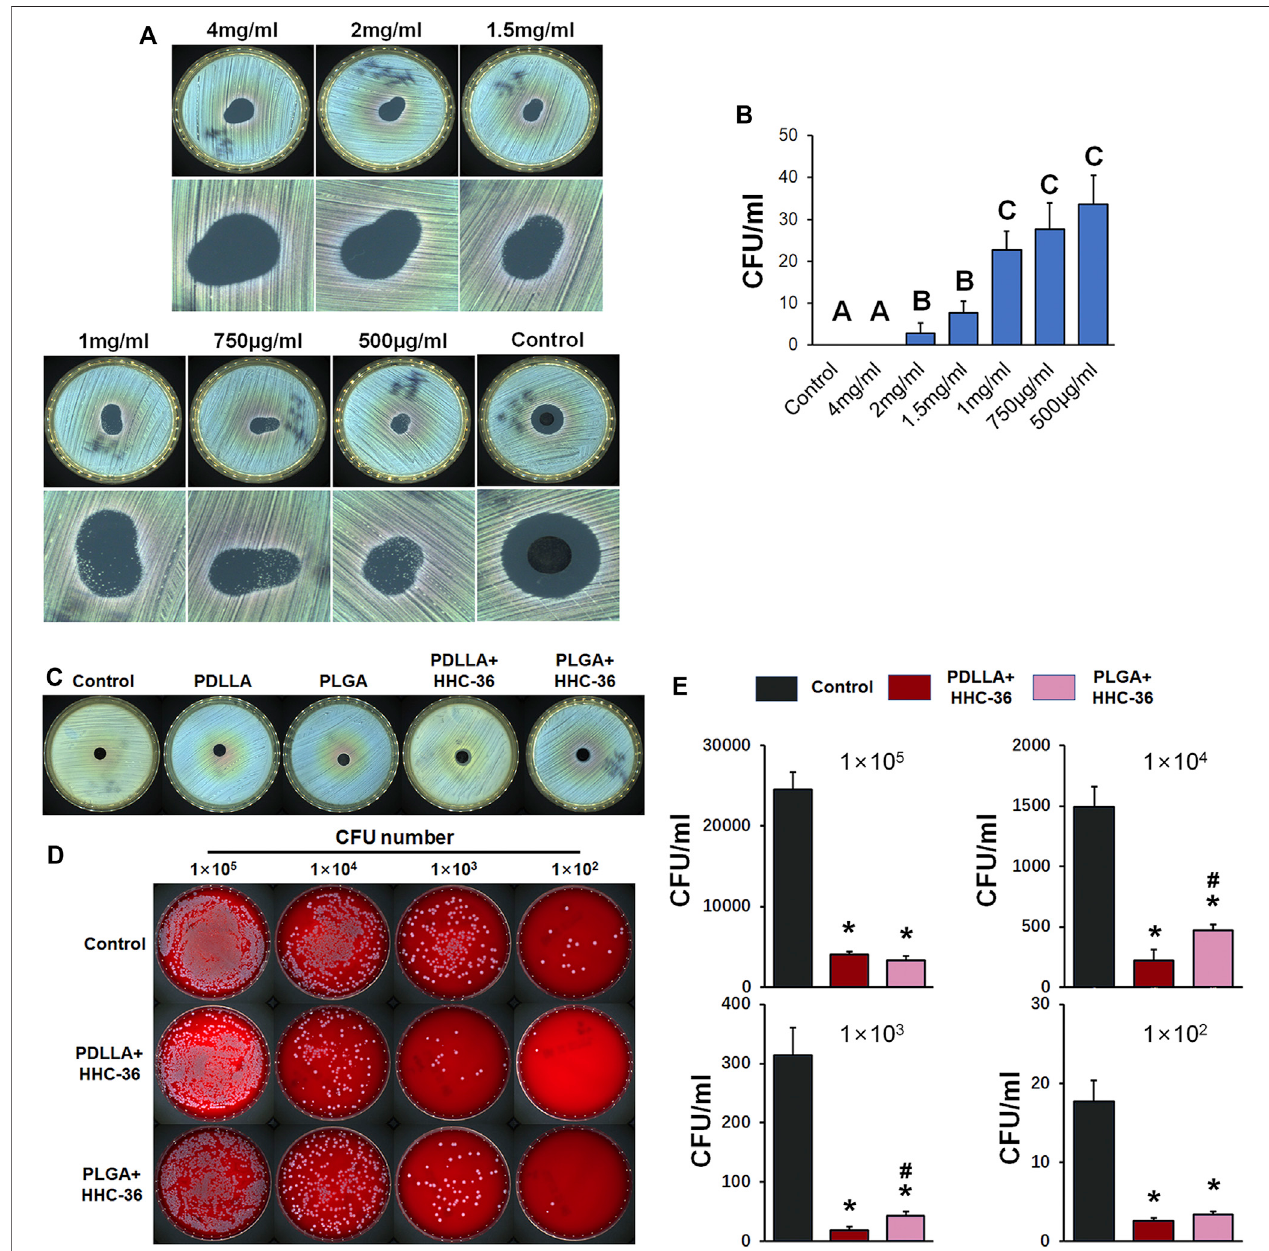
FIGURE 3 | Antibacterial property of PDLLA/PLGA-HHC-36 coated titanium nanotube in vitro . ( A ) Inhibition zone test to determine the minimum inhibitory concentration of HHC-36. ( B ) Staphylococcus aureus CFU concentration with different doses of HHC-36 at 12 h. Groups labeled with different uppercase letters are signi fi cantly different ( p < 0.05). ( C ) Inhibition zone test of un-coated titanium nanotube (control group), PDLLA/PLGA group, and PDLLA/PLGA-HHC-36 group. ( D, E ) Antibacterial property of eluent of PDLLA/PLGA-HHC-36 coated titanium nanotube. * p < 0.05 vs. Control counterparts. # p < 0.05 vs. PDLLA + HHC-36